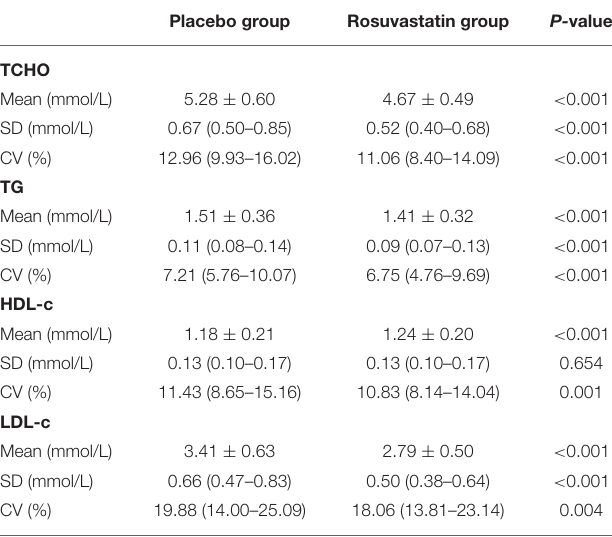
TABLE 2 | Inter-visit plasma lipid variability during the follow-up period. Placebo group Rosuvastatin group P-